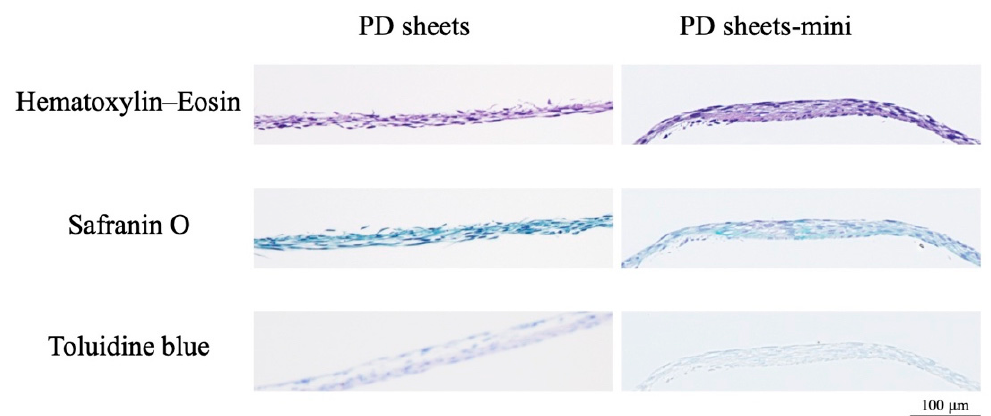
Figure 6. Histological analysis of PD sheets and mini PD sheets. Sections of both PD sheets and mini PD sheets were stained with hematoxylin–eosin, safranin O, and toluidine blue (×10, scale bar = 100 μ m).